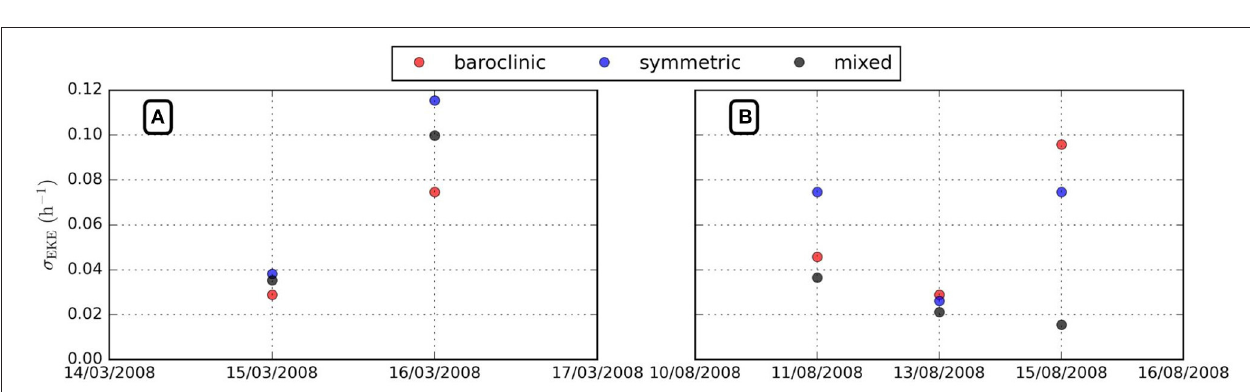
FIGURE 13 | The EKE growth rate of each instability (baroclinic in red, symmetric in blue, and mixed in black) computed between midday (previous day) and midnight in March (A) and in August (B)